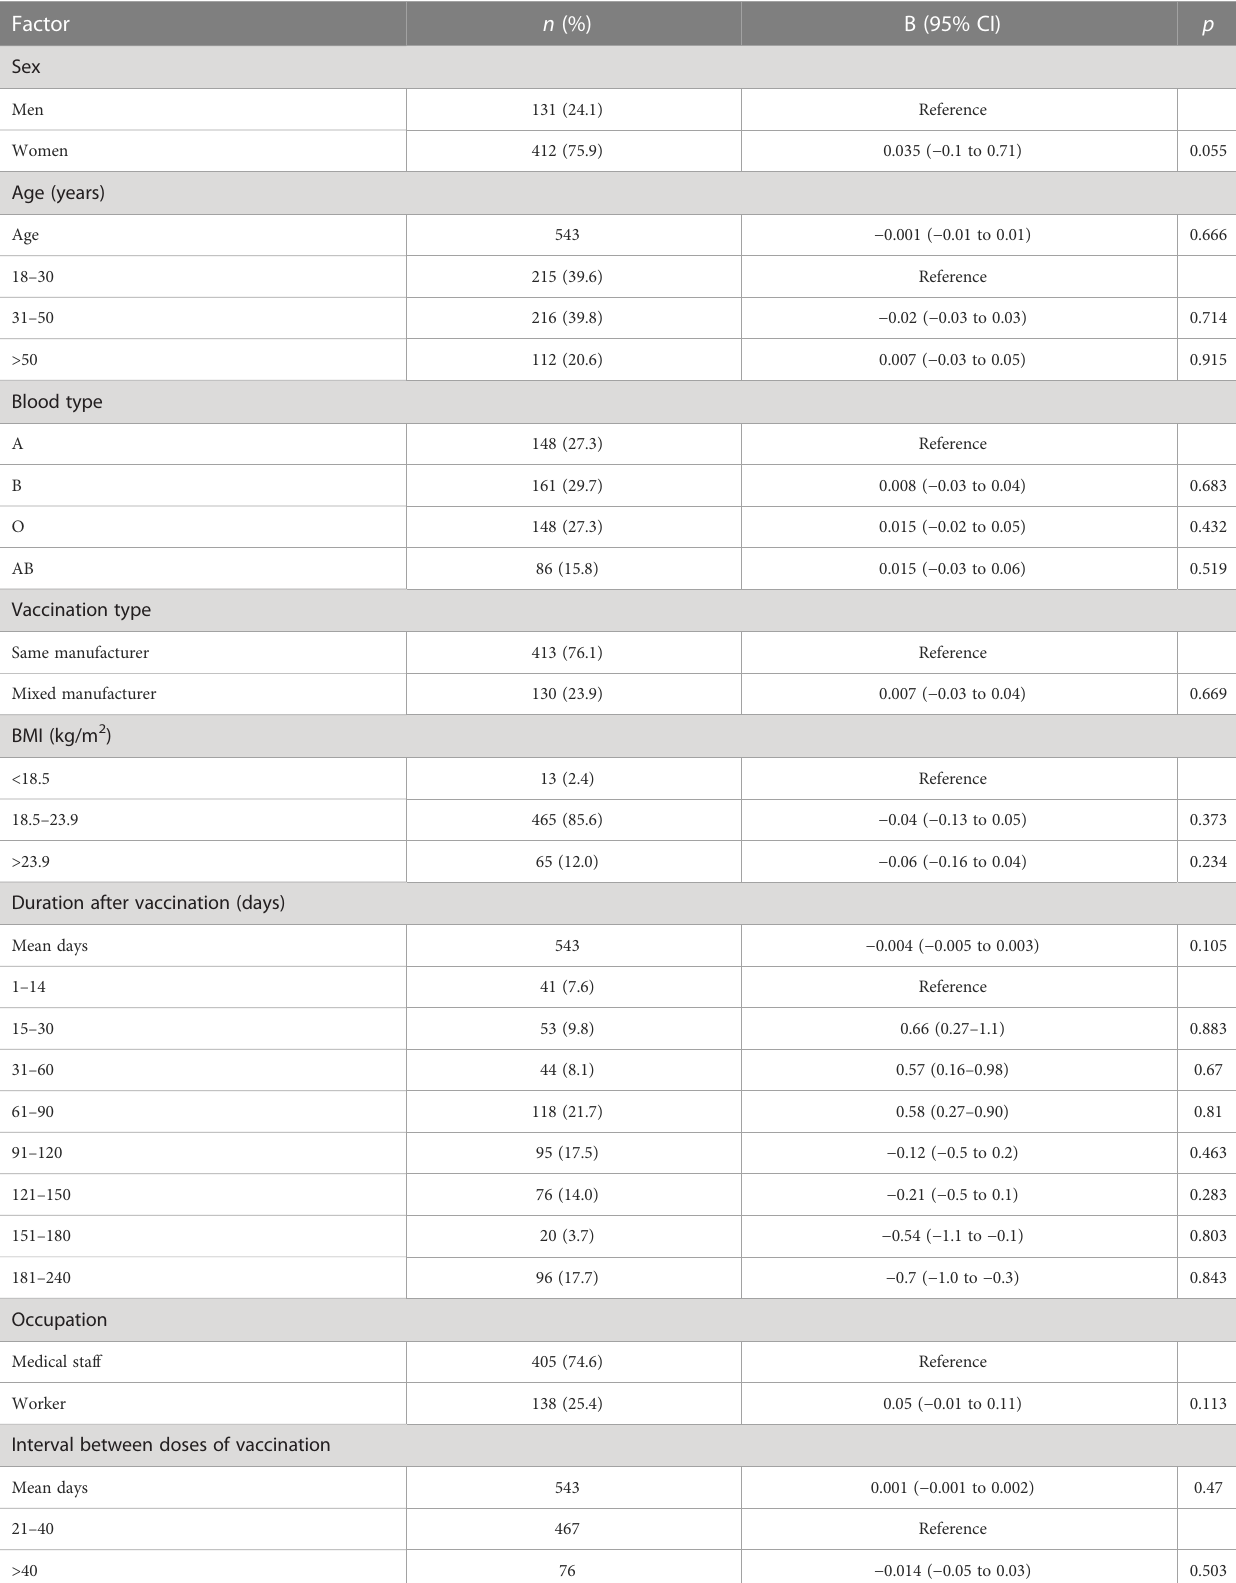
TABLE 4 Factors associated with CD4+ T-lymphocyte count after the administration of the Chinese inactivated COVID-19